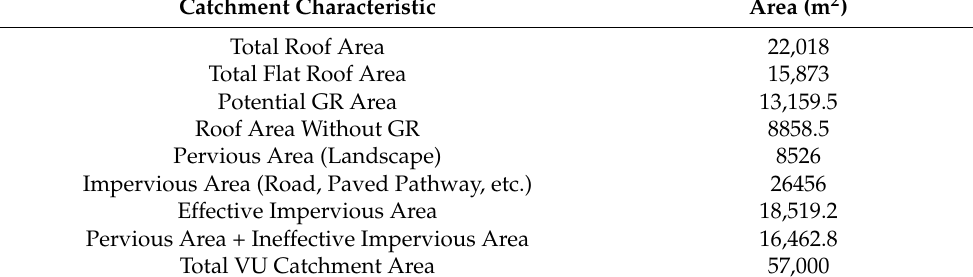
Table 2. Catchment characteristics of VU’s Footscray Park Campus.